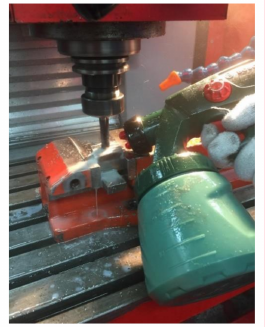
Figure 2. Test rig for machining the workpieces.